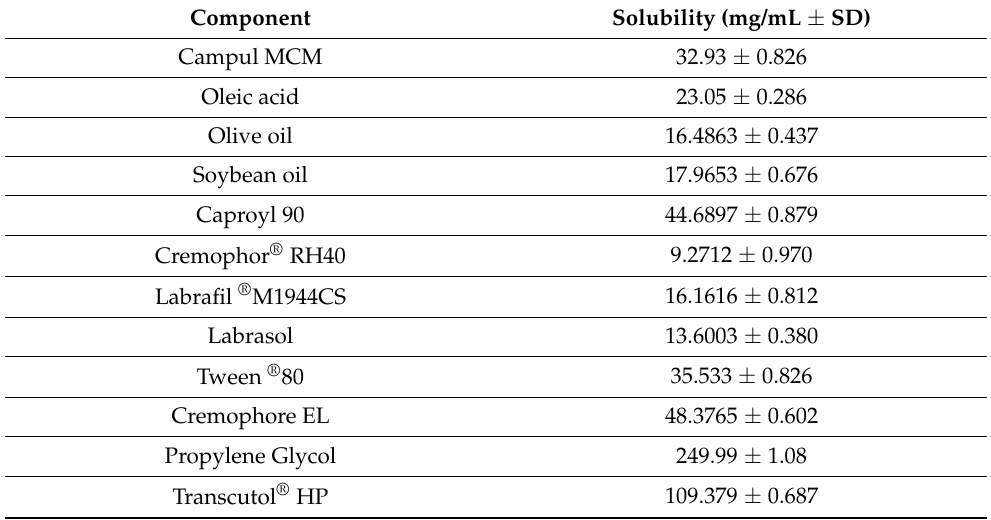
Table 1. Equilibrium solubility values of Pioglitazone HCl (PGZ) in different oils, surfactants and cosolvents at 37 ◦ C (mg/mL) ± SD